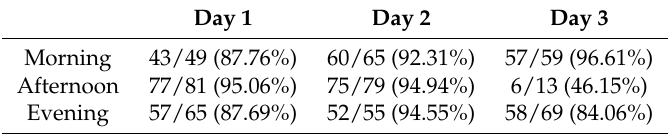
Table 4. Accuracy of our solution for each day and segment of the testing set.